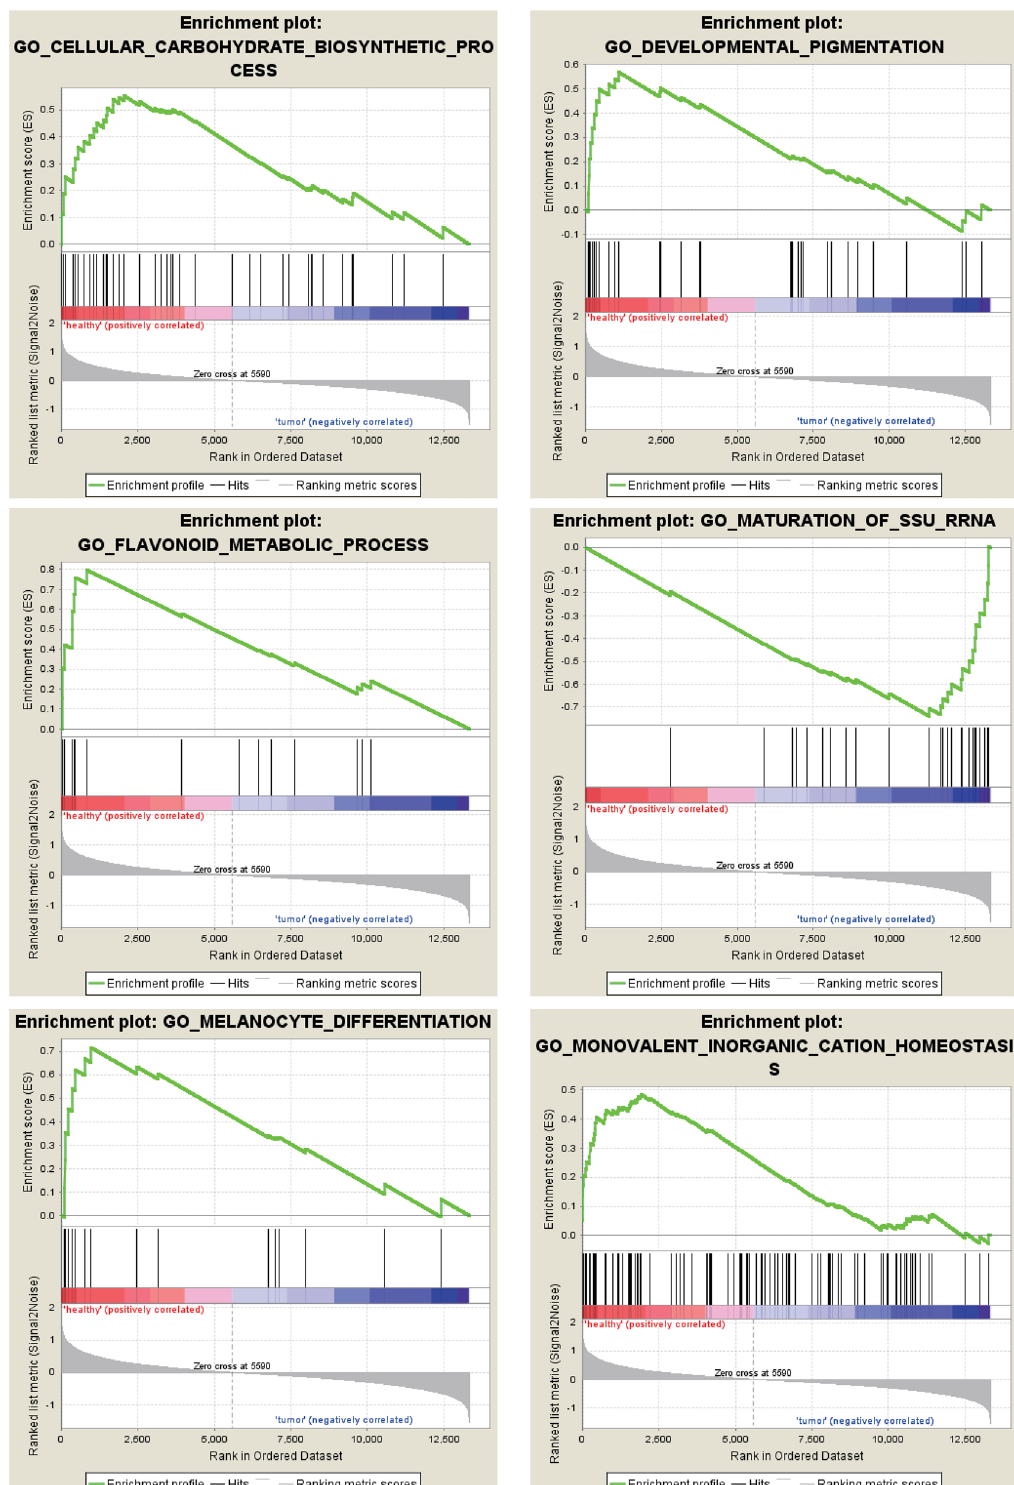
Figure 7. GO enrichment analysis for the DEGs by